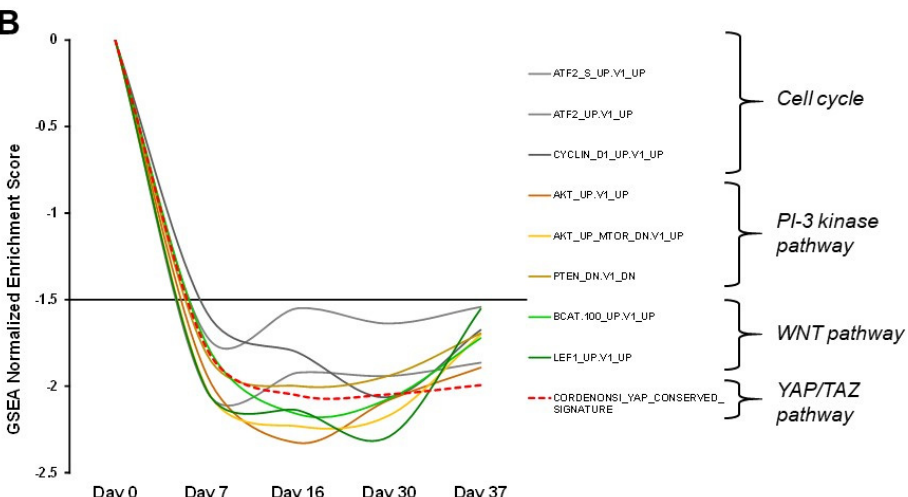
Figure 5. GSEA analysis of trametinib-driven pathway signature dynamics in the PBMC transcrip- tome. All signatures display a consistently negative Enrichment Score, below the − 1.5 significance threshold value, indicating overall down-modulation by trametinib over the entire treatment period. ( A ) Modulation of signatures related to the EGFR/RAS/RAF/MEK pathway. These include the PTPN11 RASopathy signature, highlighted by the black dashed line. ( B ) Modulation of signatures associated with additional pathways, including the YAP/TAZ pathway signature highlighted by the red dashed line.